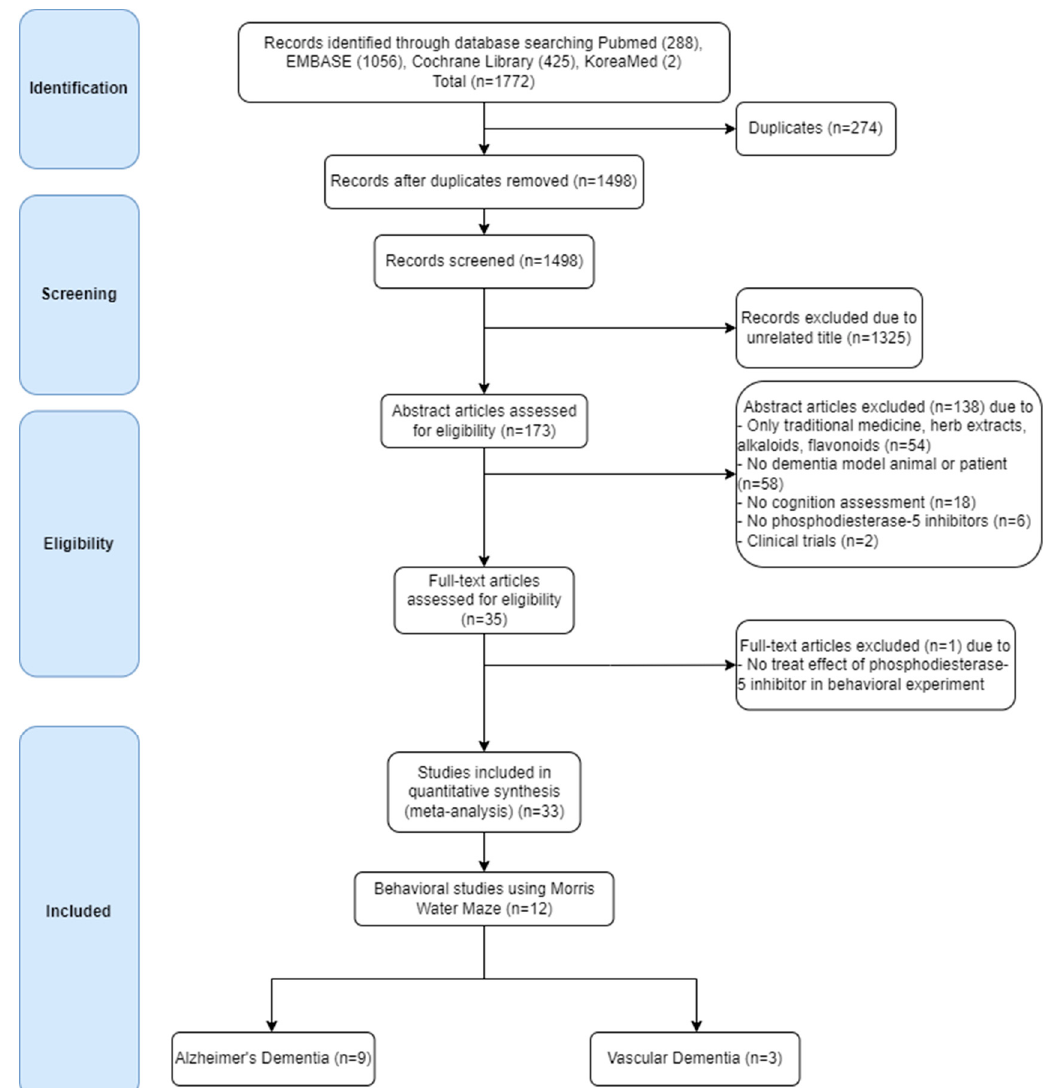
Figure 4. The phosphodiesterase-5 inhibitor study was performed independently along with the flow chart by two reviewers: (1) Duplicate articles were excluded. (2) Publications with unrelated titles and abstracts were excluded. (3) According to the eligibility, publications that had no therapeutic effect in the behavioral experiment were excluded. (4) Full-text articles that were not available for meta-analysis, that had no animal, cognition, or Morris water maze test, were excluded.